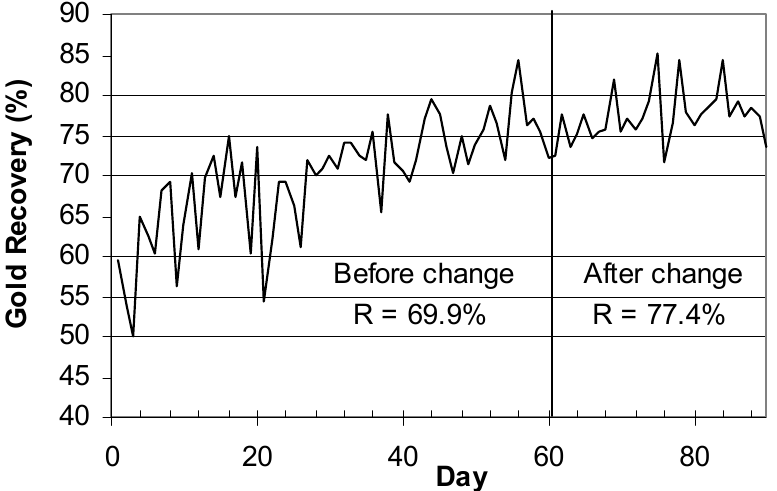
Figure 4. Daily gold recovery before and after the introduction of a new flotation